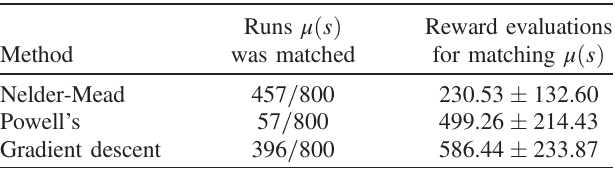
TABLE II. The second column shows the number of runs that achieved similar or better rewards than our RL approach with the corresponding method. The third column provides the number of reward function evaluations that were required until our RL approach was matched.